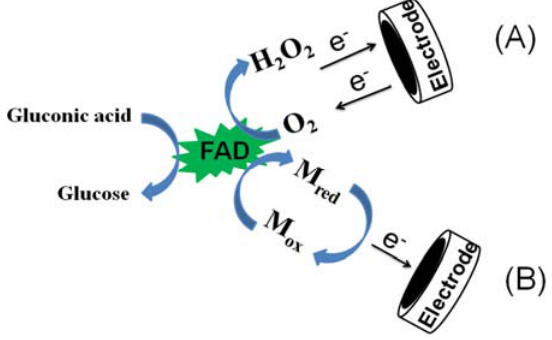
Figure 2. (A) A schematic illustration of the first generation and (B) the second generation amperometric glucose sensors (redrawn from reference